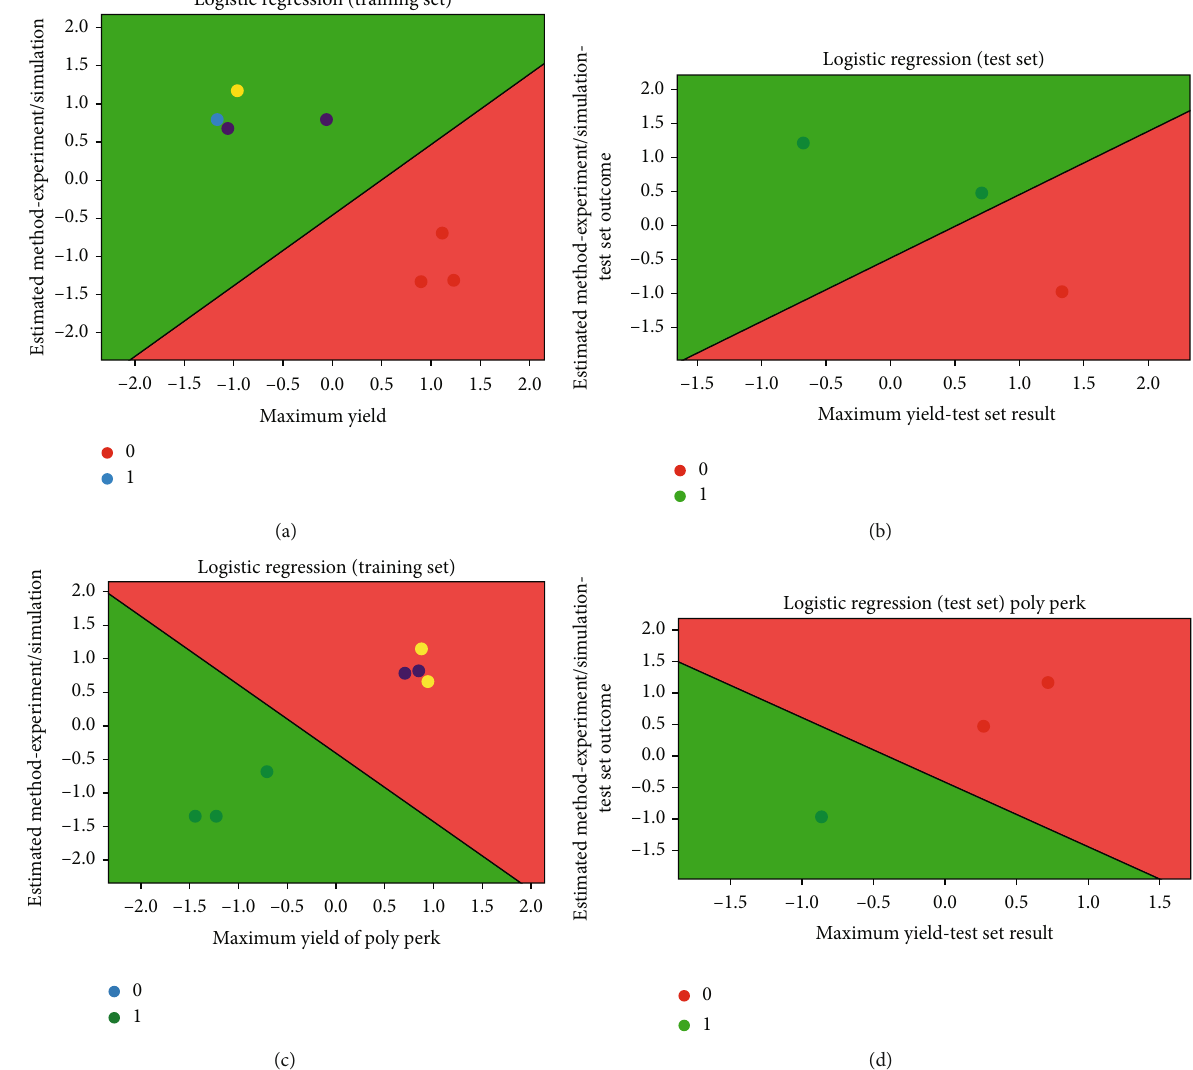
Figure 14: Working data sets of monoperk and polyperk modules using logistic regression: (a) training set of monoperk module; (b) testing set of monoperk module; (c) training set of polyperk module; (d) training set of polyperk